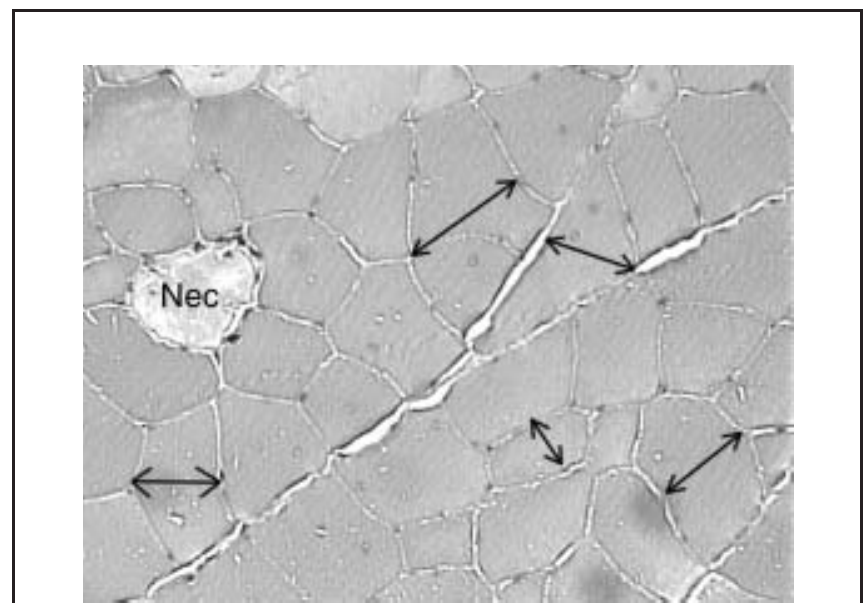
Figure 1: Light micrograph of a 5 µm wax embedded toluidine blue stained section showing cross-sectioned myofibres in a treated muscle. The arrows mark the diameters used for morphometery. A necrotic myofibre (Nec) is seen. 10X